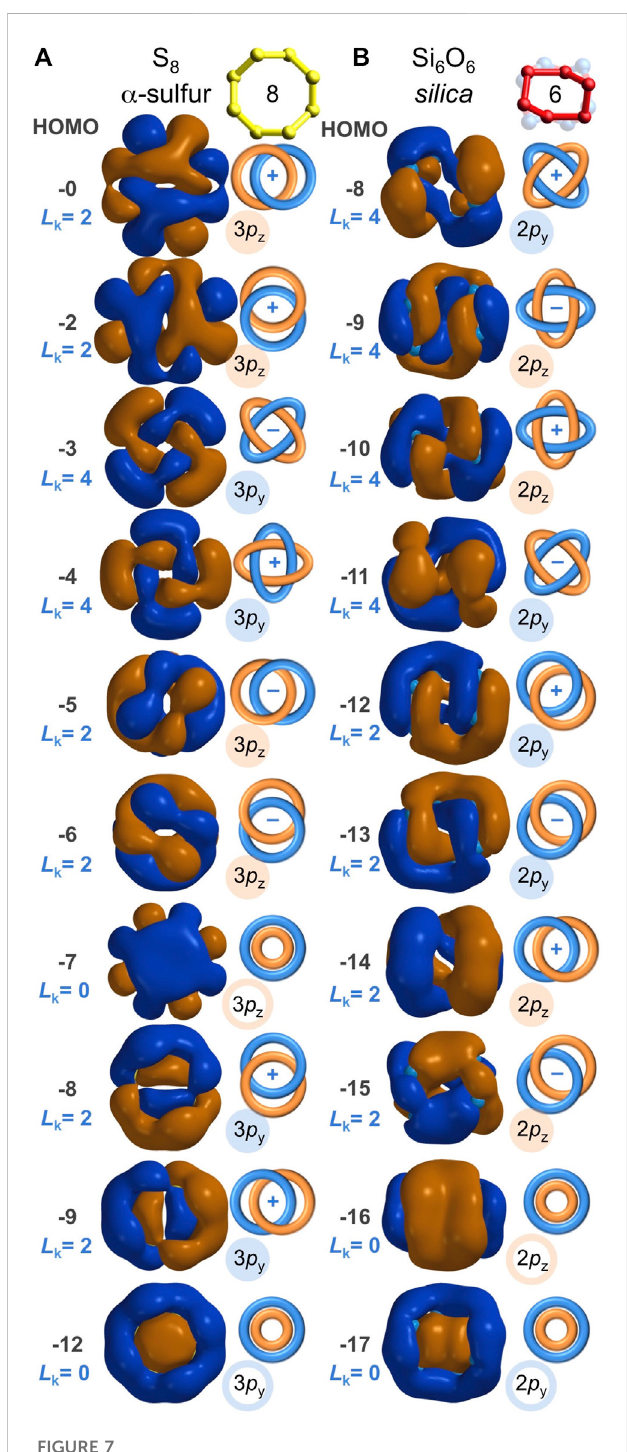
FIGURE 7 Analogous sulfur-based and oxygen-based valence molecular orbitals (IsoValue = 0.005 [e/bohr 3 ] 0.5 ) for α -sulfur S 8 (A) and for Si 6 O 6 found in quartz silica (B) . These molecular orbitals are built from contiguous p orbitals with a bonding excess of be 3 p = 100% and be 2 p = 100%, respectively, resulting in both Hückel ( L k = 0) and Möbius ( L k = 2 or 4) aromaticity. Their resemblance warrants equal expectations for covalent S-S bonding in sulfur and covalent O-O bonding in